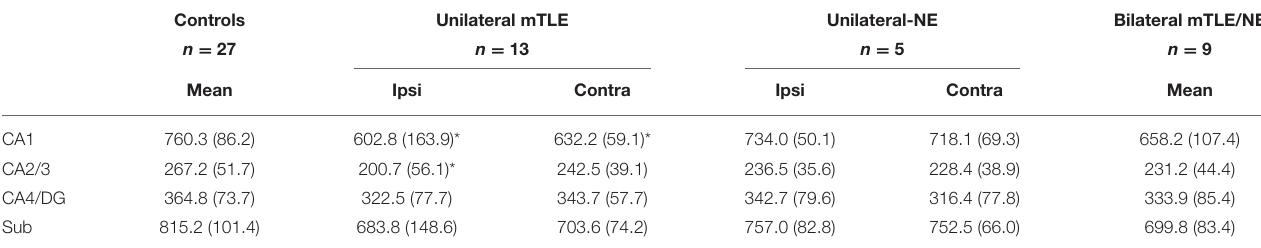
TABLE 2 | Mean (SD) of hippocampal subfield volumes. Controls Unilateral mTLE